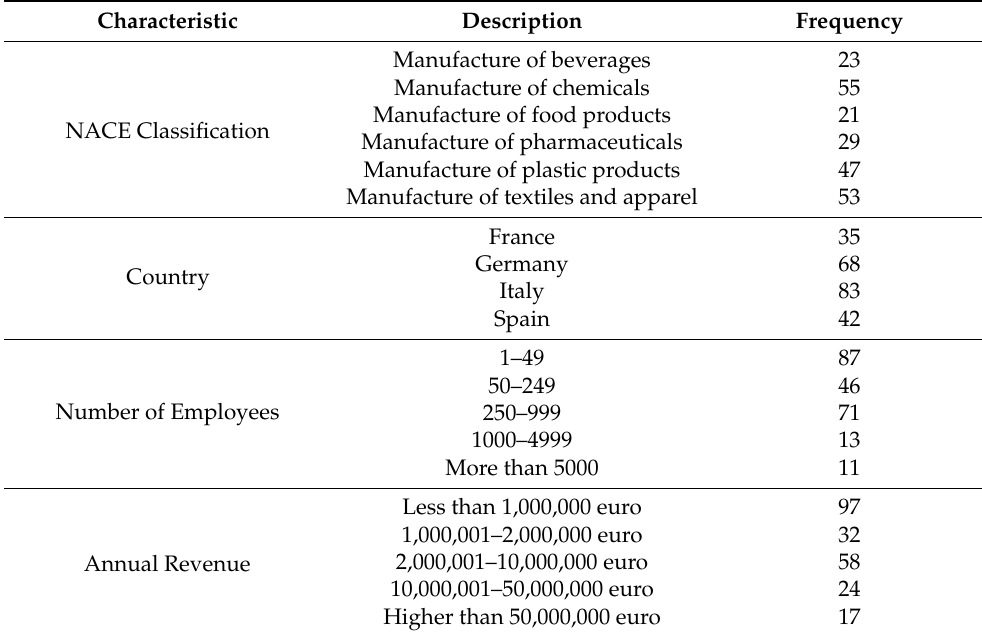
Table 1. Sample description.